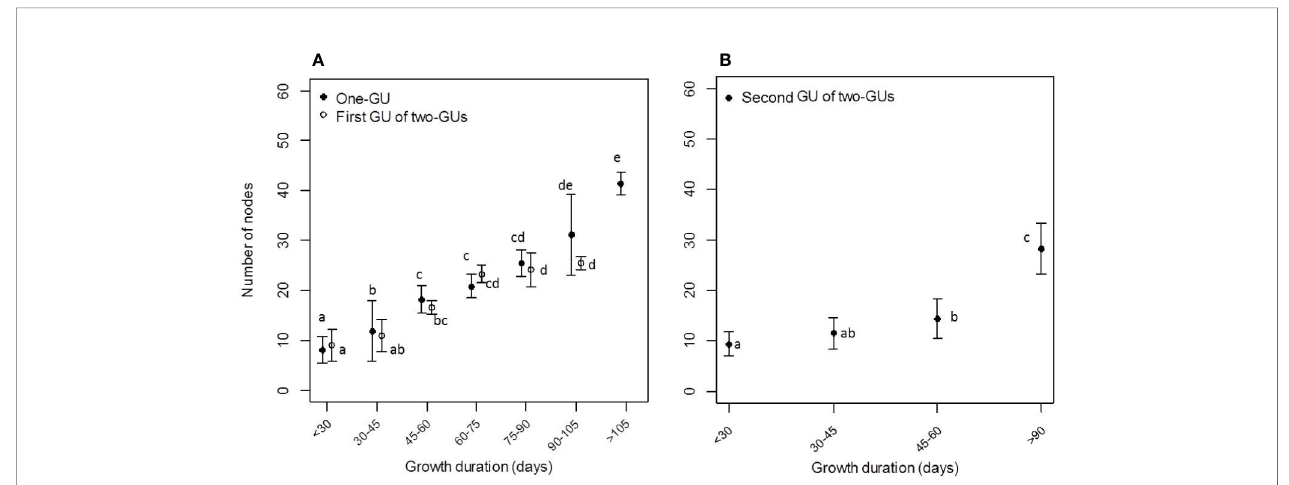
FIGURE 3 | Mean node number and shoot length of the one-GU shoots (A) , fi rst GU (A) , and second GU (B) of the two-GU shoots for different ranges of growth duration (GD). Different letters indicate signi fi cant differences in the number of nodes between different classes of GD for a given GU.